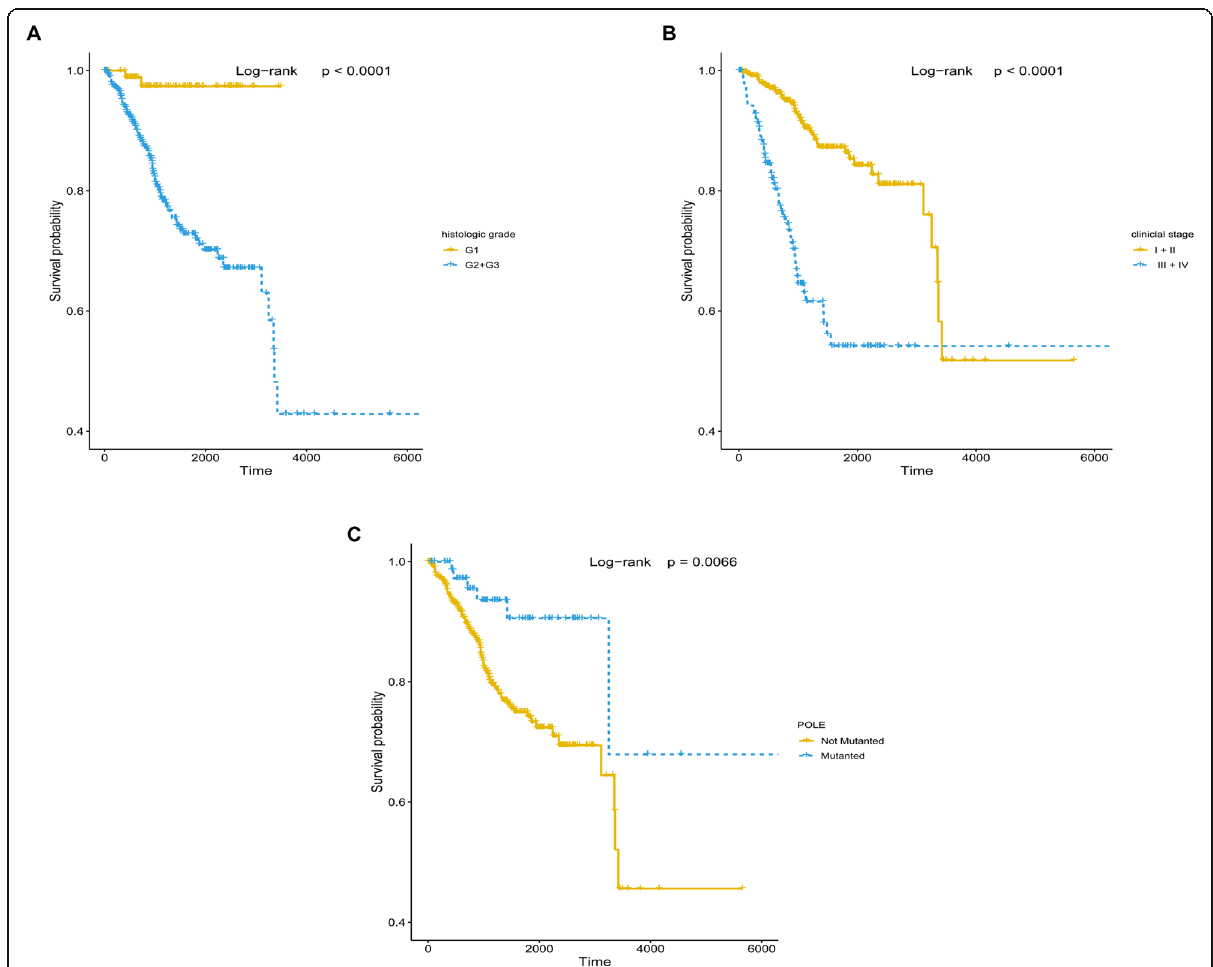
Fig. 2 Histologic grade, clinical stage, and POLE mutational status are independent prognostic factors for endometrial cancer patients. a Kaplan – Meier curve and log-rank test for endometrial cancer patients based on histologic grade classification. b Kaplan – Meier curve and log-rank test for endometrial cancer patients based on clinical stage classification. c Kaplan – Meier curve and log-rank test for endometrial cancer patients based